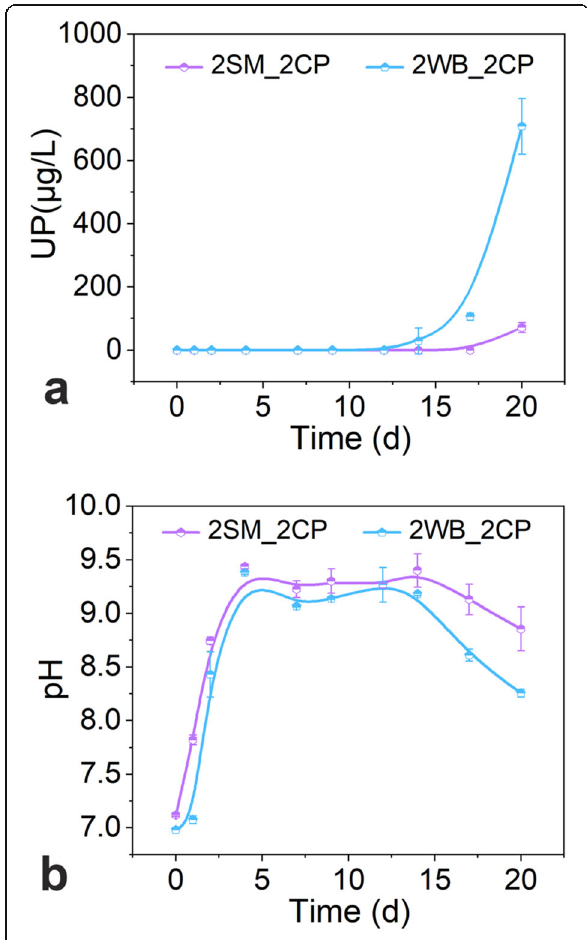
Fig. 4 Effect of CP on fermentation performance of S. coelicolor CGMC C 4.7172. a and b The variation of UP concentrations and pH values in 2SM_2CP and 2WB_2CP media, respectively, during the fermentation process of 20